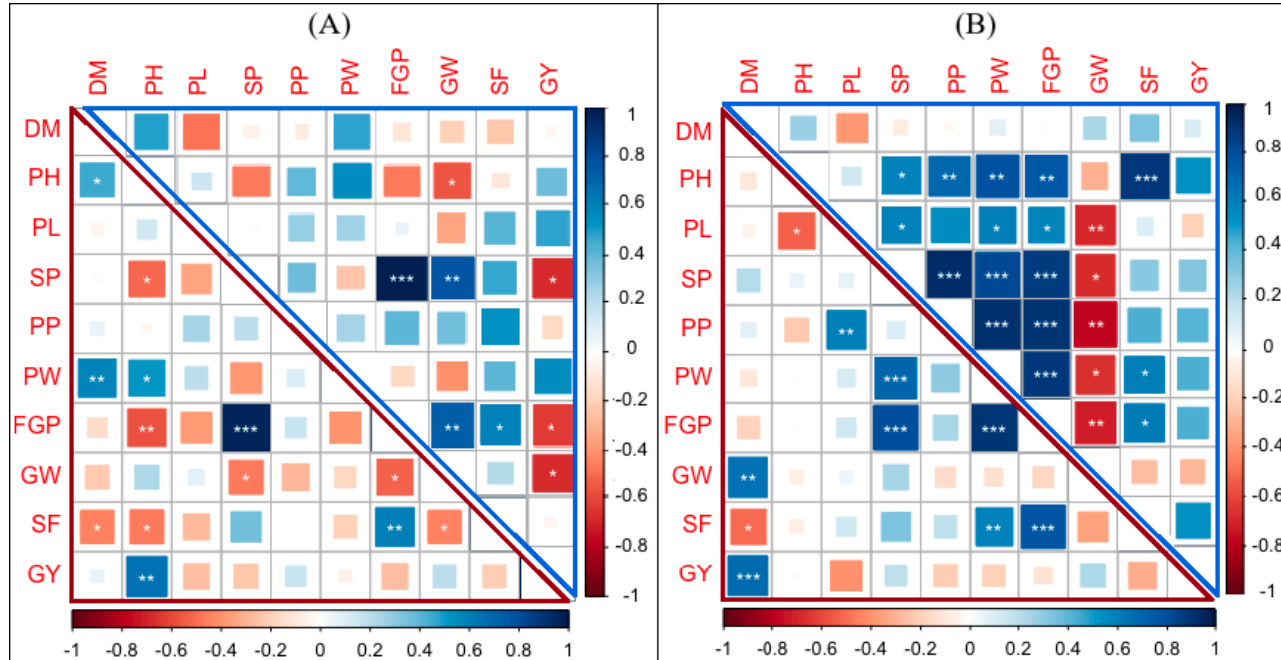
Figure 4. Corrplot depicting Pearson’s correlation between the general and specific combining ability for 10 yield traits across 29 genotypes. Red squares indicate a negative correlation; blue squares indicate a positive correlation; and white squares indicate no correlation. ( A ) GCAs (upper triangle) and SCAs (lower triangle) under normal growth conditions. ( B ) GCAs (upper triangle) and SCAs (lower triangle) under water-stress conditions. The asterisks indicate significant correlations using a two-tailed t-test (** p < 0.05; and *** p < 0.01).